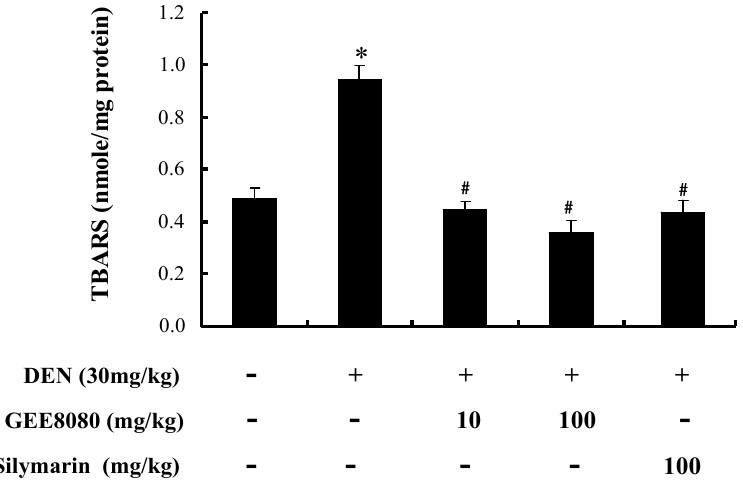
Figure 7. Effects of ginger extracts administration on the activities of hepatic TBARS content in DEN-treated mice. Each value represents the mean ± S.D for 5 mice. * p < 0.05, significantly different from the unstimulated control group. # p < 0.05, significant differences from the DEN-treated